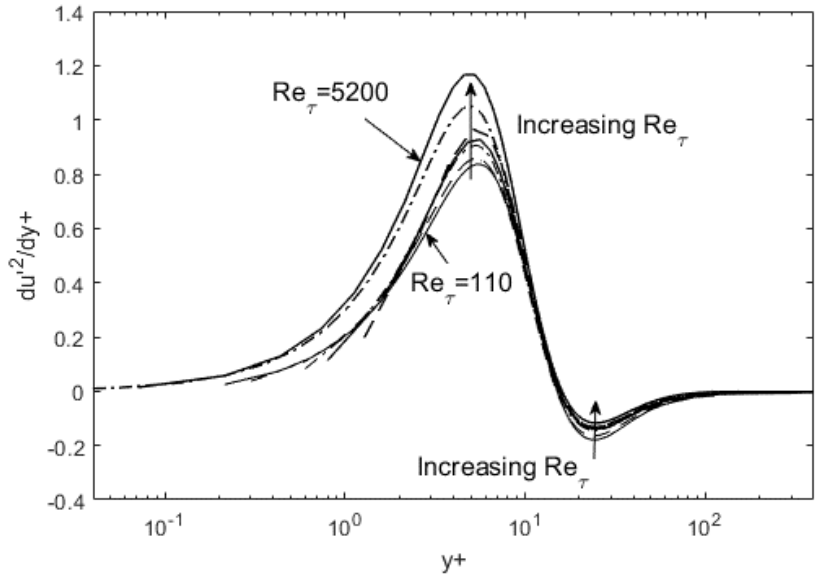
Figure 1. The dissipation scaling of du’ 2 /dy+. The near-wall peaks increase and the negative gradi- ents reduce in magnitude with increasing Reynolds number. DNS data of Iwamoto et al. [11] and Graham et al. [12] are used.